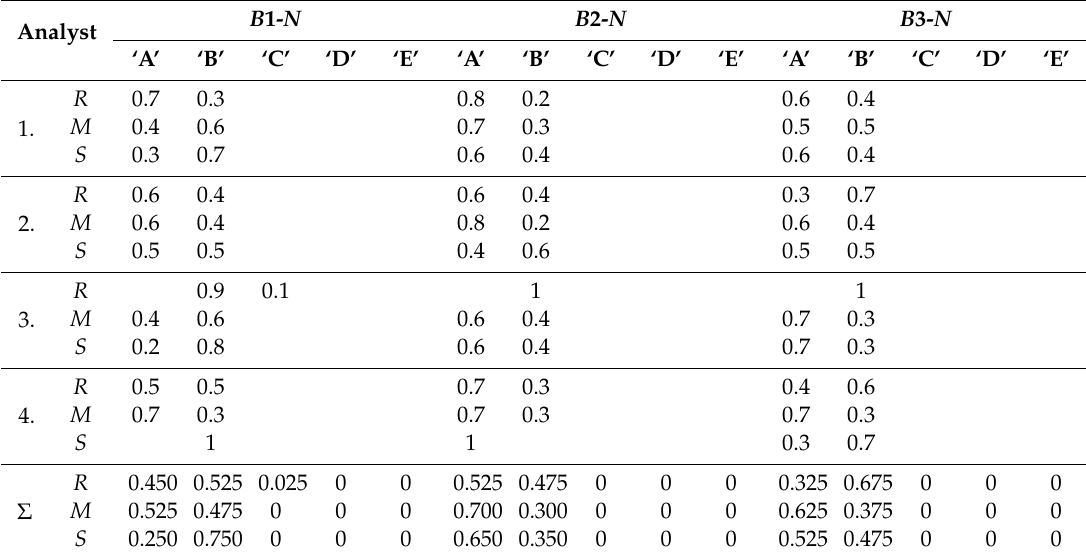
Table 4. Results of questionnaire for new